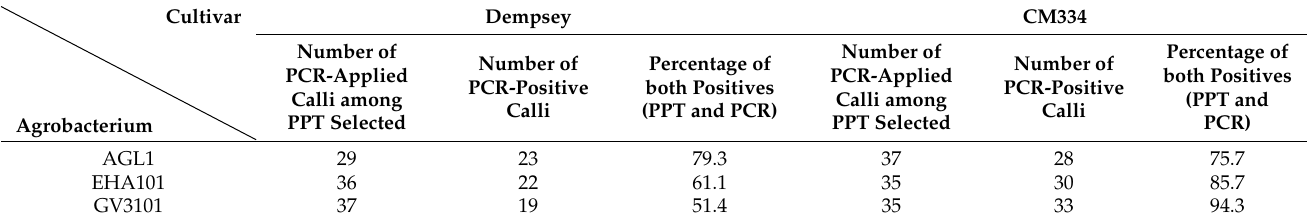
Table 1. Summary of the percentages of positive (PCR and PPT) transformants in cv. Dempsey and CM334. Cultivar Dempsey